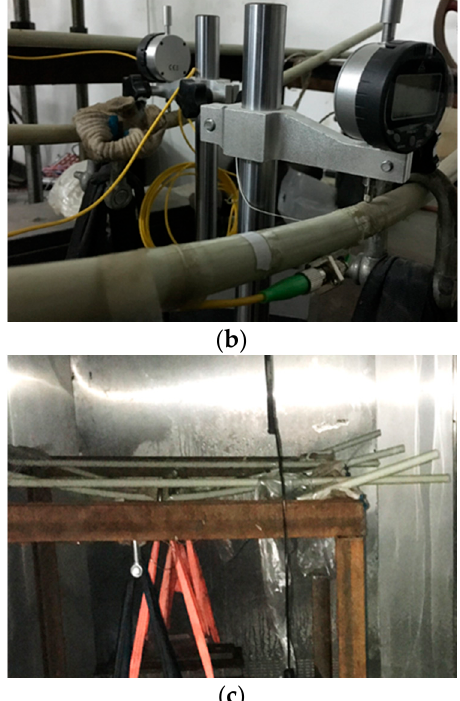
Figure 3. Creep test setup: ( a ) Diagram of creep test setup showing the position of dial gauge D and the location of strain sensors ( S 1 and S 2 ) ; ( b ) Creep test in laboratory condition; ( c ) Creep test inside the environmental chamber.